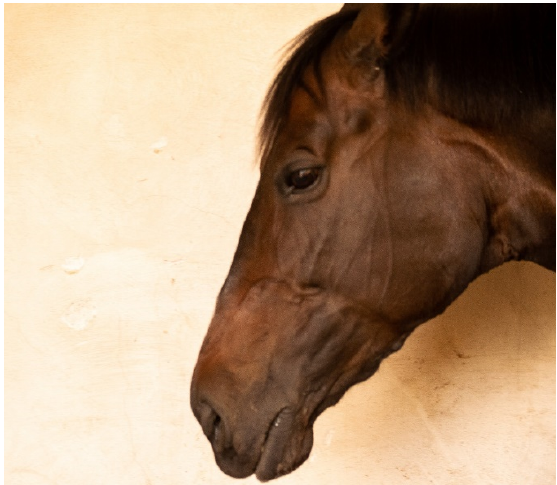
Figure 6. Photograph of profile of horse in which examiners ( n = 2) agreed there was confirmed exostosis on the mandible. Photograph courtesy of Missael García-Márquez. Table 5. Distribution of categories of lesions in mandible bones as detected by two examiners conducting visual inspection and palpation.